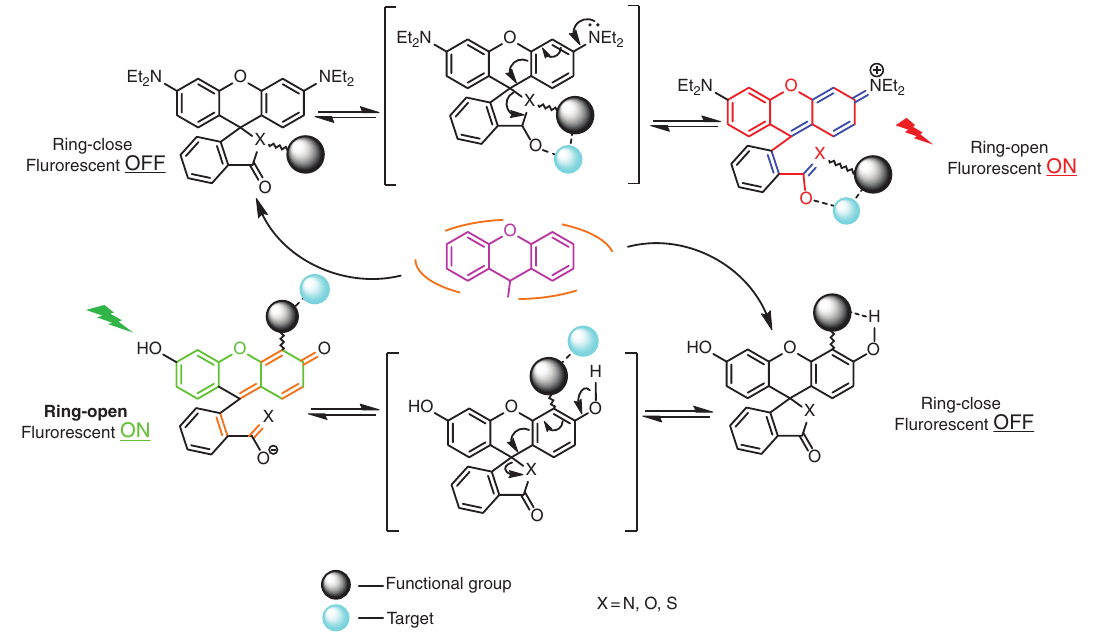
Figure 2: Recognition mechanism of fluorescent probes based on xanthene for detecting metal